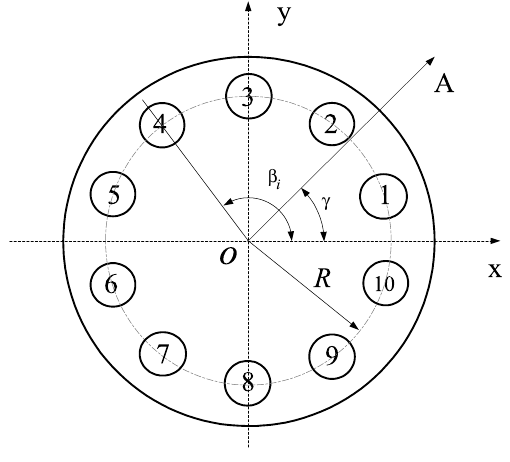
Fig. 3. Configuration of thrust pad